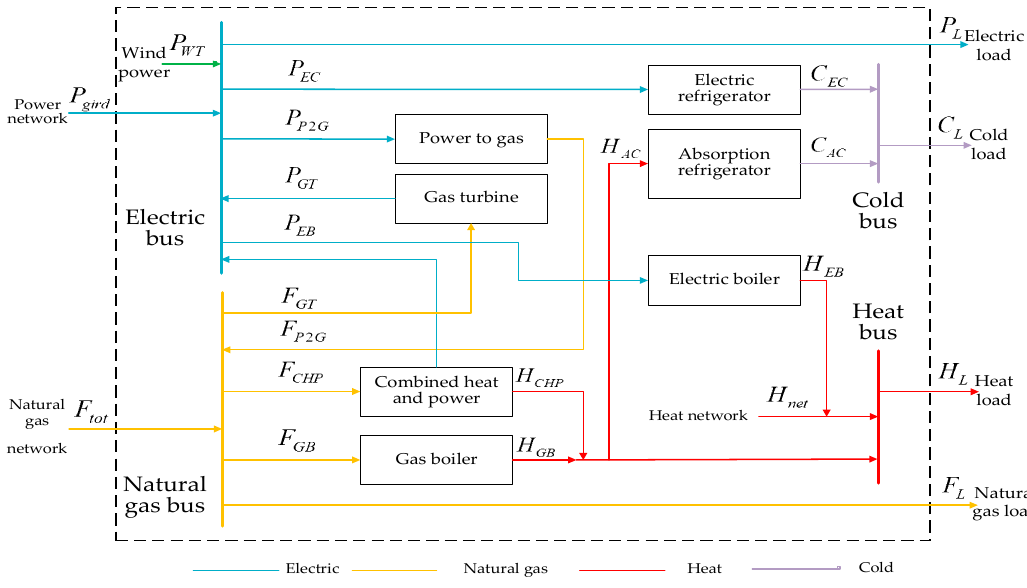
Figure 7. Integrated energy system structure.